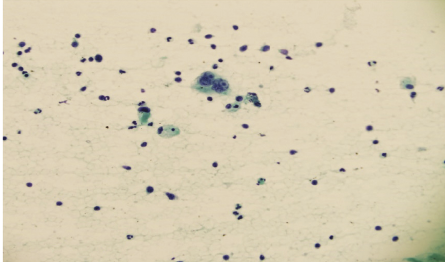
Figure 4: Right paratracheal lymph node biopsy via EBUS-TBNA with Papanicolaou stain showing Reed–Sternberg cells ( × 400).